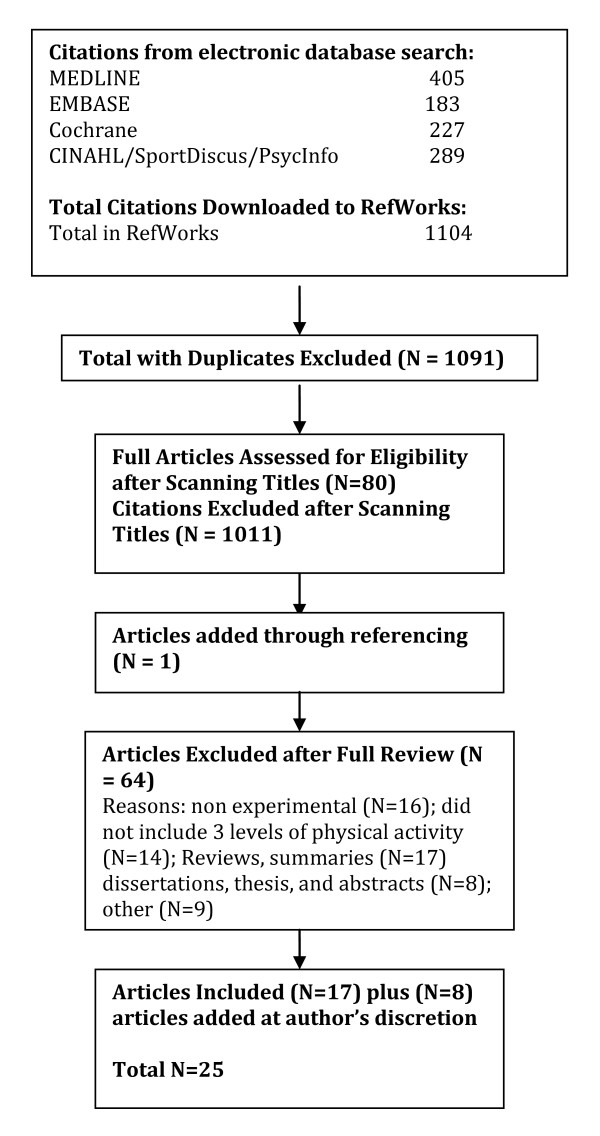
Results of the Literature Search for Stroke.